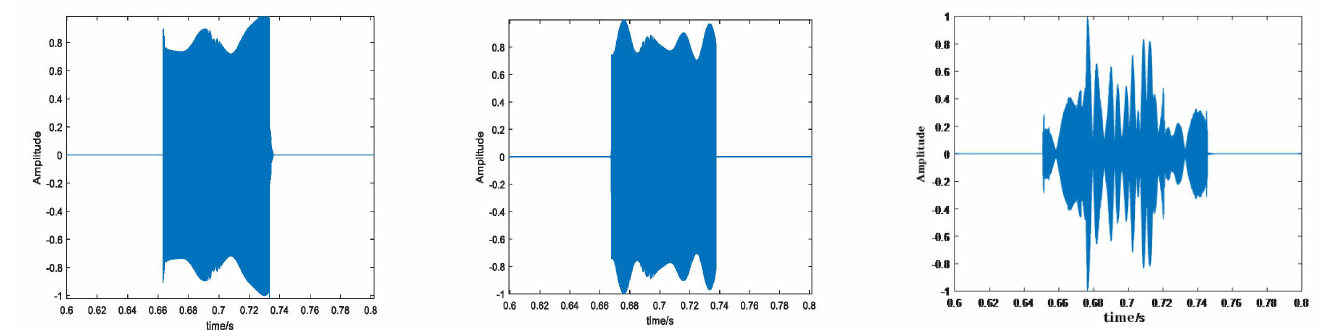
Figure 10. Time domain echo signals of different targets.